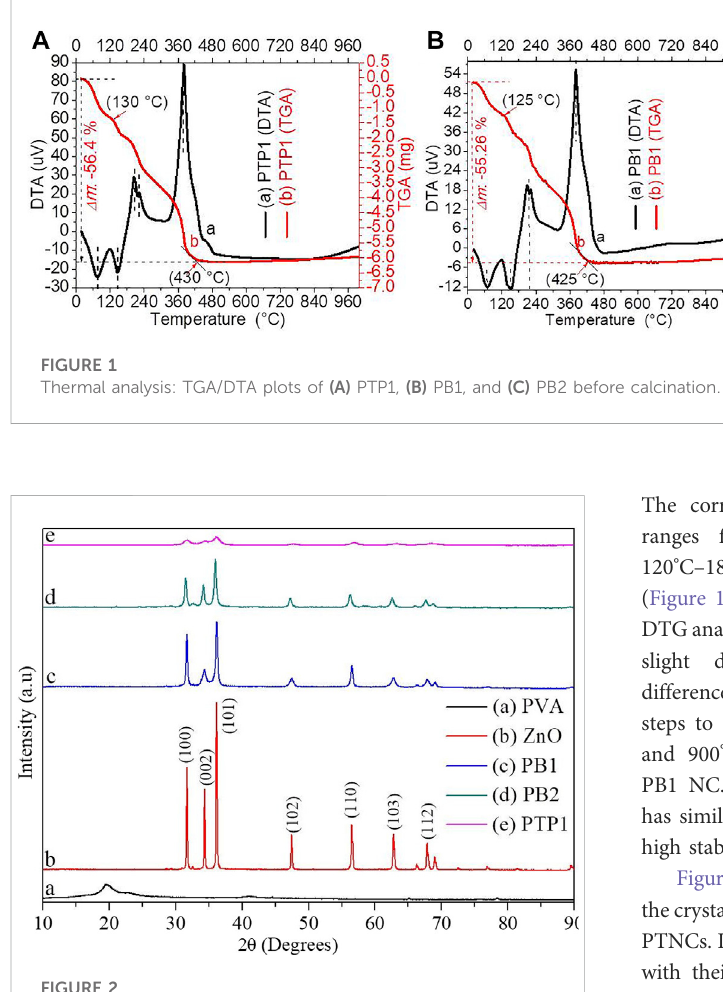
FIGURE 2 Structureandcrystallinityanalysis:XRDpatternsforPVA,ZnO NPs and PB1, PB2, and PTP1 NCs calcined at 500 °